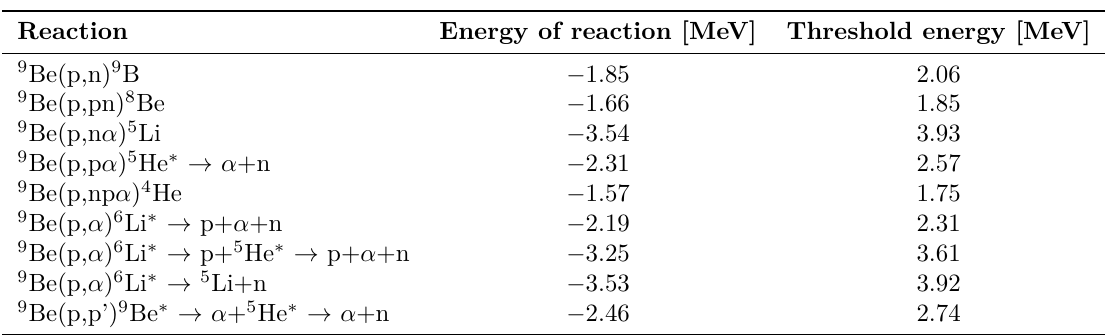
Table 1. Reactions of protons with beryllium which produce neutrons [3, 4].